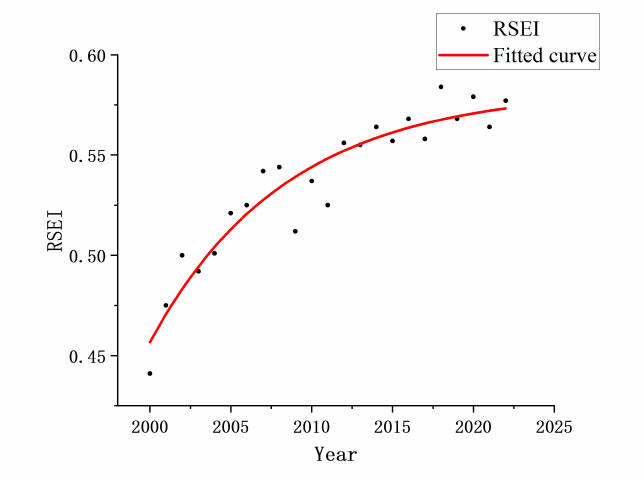
Figure 4. A logarithmic growth in EE improvement since 2002.